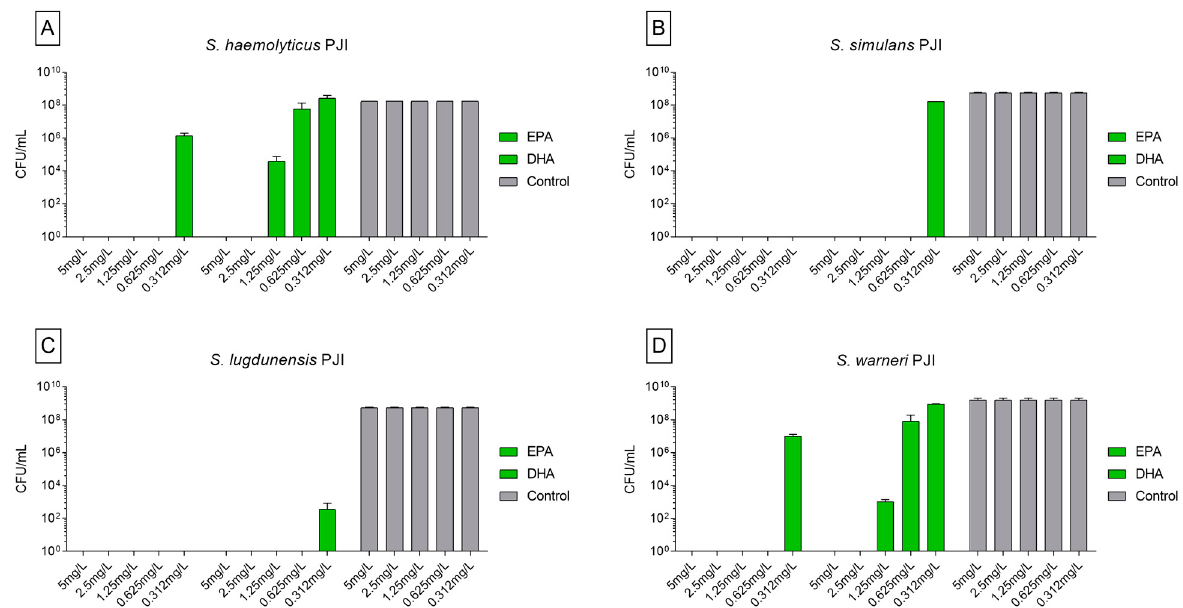
Figure 2. Activity of ω -3 PUFAs on planktonic cells analyzed by counting of colony forming units of patient isolated strains incubated with EPA, DHA, and only with nutrient medium as control. The data are stated as mean ± SEM. ( A ) S. haemolyticus PJI patient isolate; ( B ) S. simulans PJI patient isolate; ( C ) S. lugdunensis PJI patient isolate; ( D ) S. warneri PJI patient isolate. In green, values significantly different from control group ( S. haemolyticus and S. warneri p < 0.05; S. simulans and S. lugdunensis p < 0.0001). Statistical analyzed with two-way ANOVA and Turkey’s multiple comparison tests. All the tests were repeated twice and carried out in triplicates.